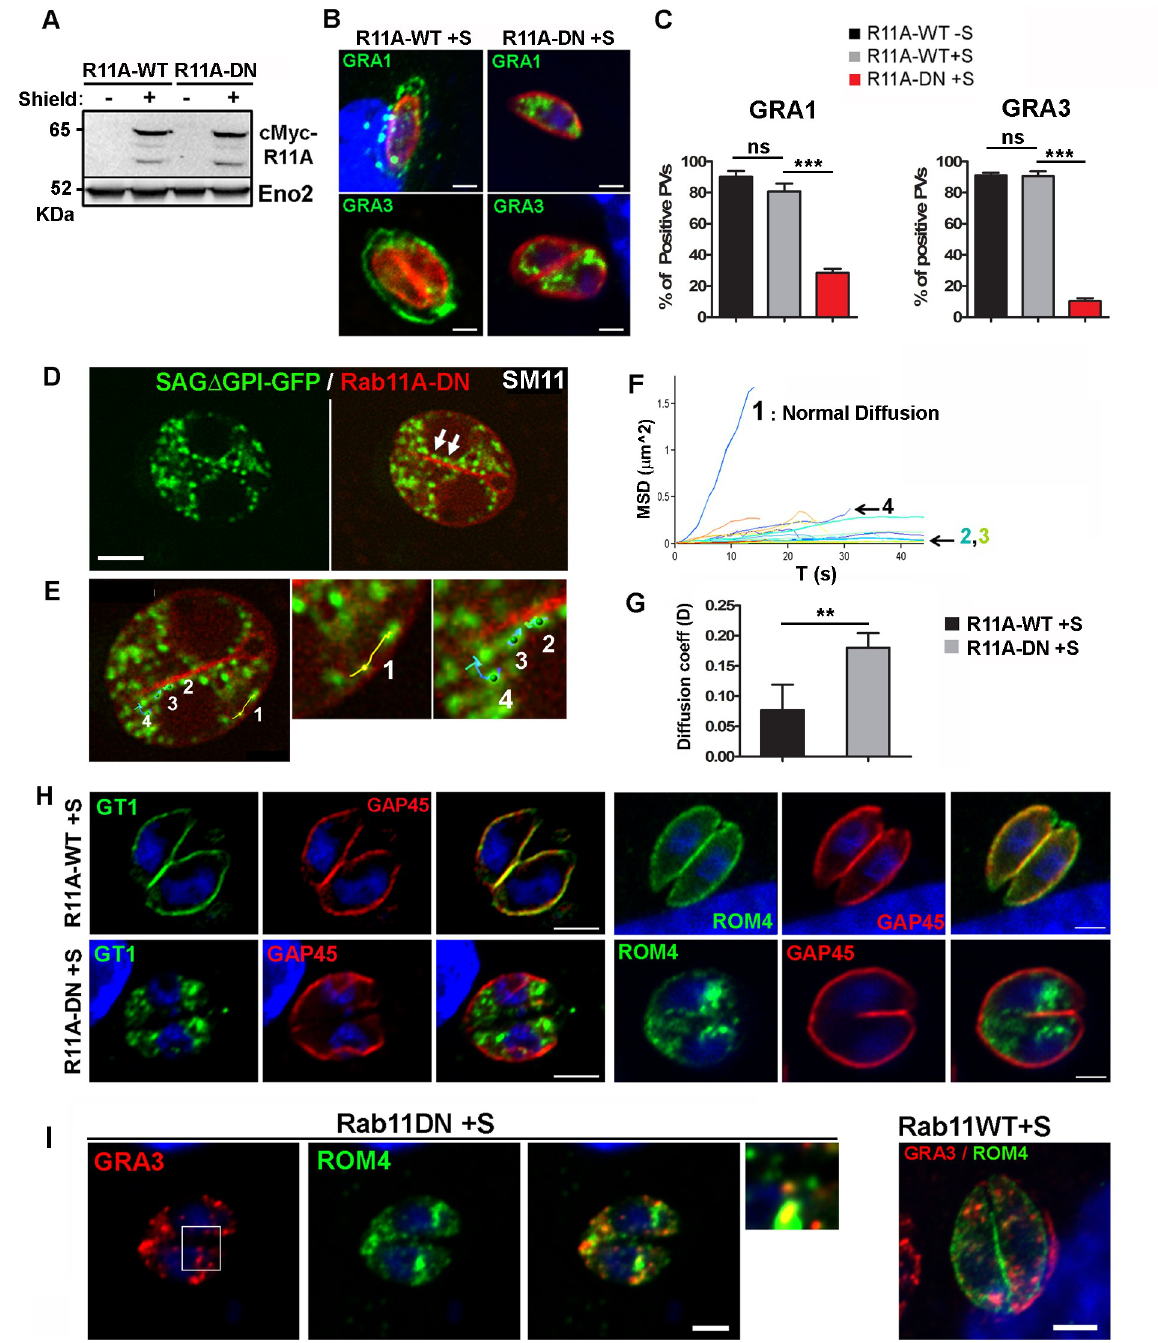
Fig 3. A- Western blot analysis using anti-Rab11A antibodies showing Rab11A-WT and Rab11A-DN proteins in similar amounts after 4 h of Shield-1 induction (+S) of intracellular tachyzoites. Eno2 is used as a loading control. B- Immunofluorescence assay (IFA) showing the dense granule proteins GRA1 and GRA3 (green) retained in intra-cytosolic vesicles following 2 h (upper panel) and 4 h (lower panel) of Shield-1 induction of Rab11A-DN parasites, while being efficiently released into the vacuolar space and at the vacuole membrane in similarly induced Rab11A-WT parasites. The parasite cortex is delineated by the glideosome protein GAP45 (red). Bars: 1 μ m. C- Percentage of vacuoles positive for GRA1 and GRA3 secretion in Rab11A-WT and Rab11A-DN parasites induced (+S) or not (-S) with Shield-1. Data show mean ± SEM of three independent experiments (unpaired Student’s t -test, GRA1: ��� p < 0.0001 et GRA3: ��� p = 0.0008). D - Image extracted from S11 Movie illustrating DG movements in mcherryRab11A-DN (red) / SAG Δ GPI-GFP expressing parasites. DGs accumulate in the parasite cytosol or remain stationary along the segregating membrane of daughter cells (arrows). Bar: 2 μ m. E- Images extracted from S11 Movie showing the tracking of 4